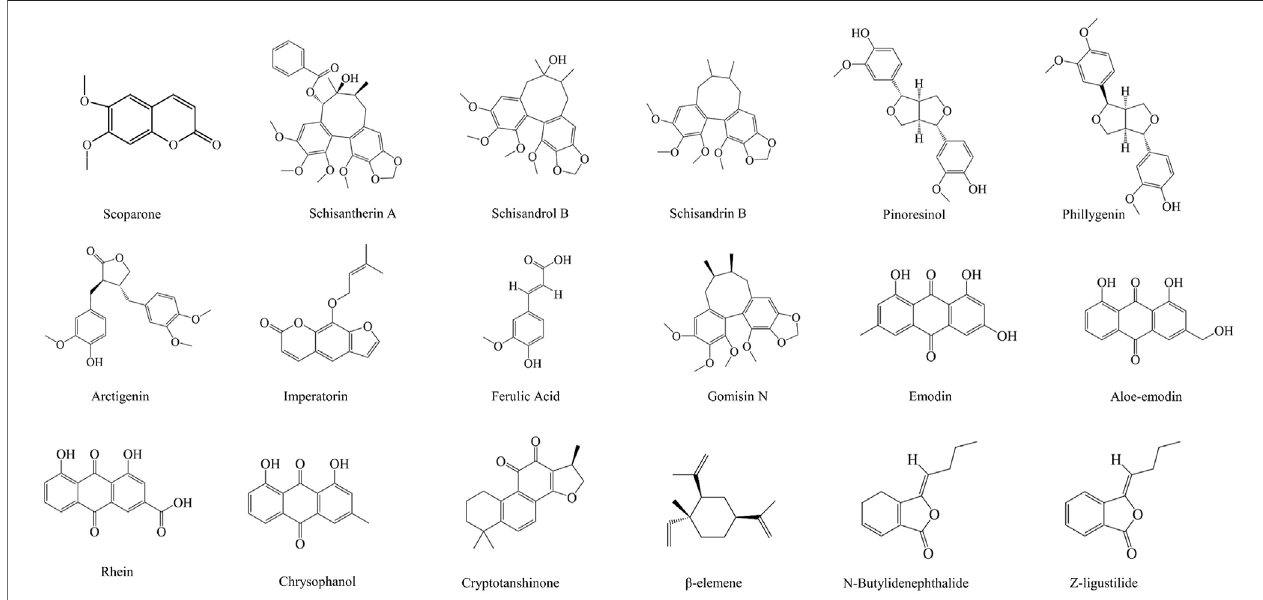
FIGURE 9 | The related chemical structures of other anti-hepatopathy bioactive